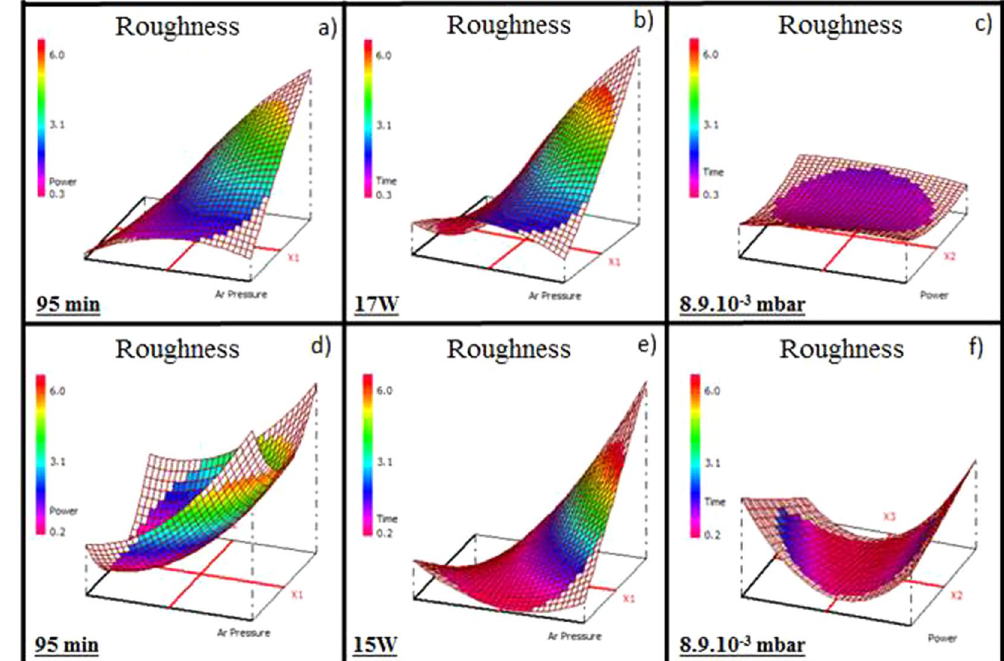
Figure 7. Variation of the surface roughness of the Ge 28.1 Sb 6.3 Se 65.6 thin films for ( a ) a fixed deposition time of 95 min, ( b ) a fixed working power of 17 W, ( c ) a fixed Ar pressure of 8.9.10 − 3 mbar and the Ge 12.5 Sb 25 Se